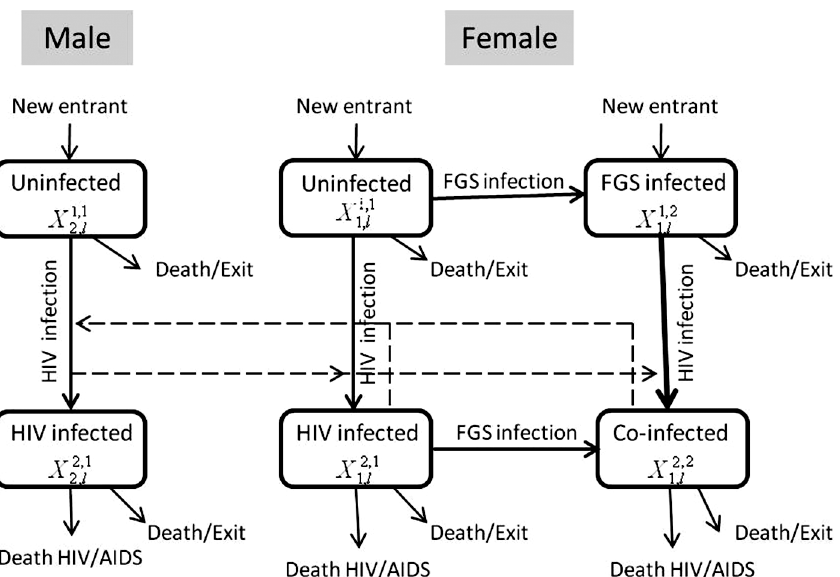
Figure 1. Outline of FGS-HIV transmission model. The flow between epidemiological classes for the transmission dynamics of FGS and HIV. Individuals enter the system at age 15, and exit at age 50. X 1,1 and FGS, infected with FGS, infected with HIV, and infected with both HIV and FGS. X 1,1 and infected with HIV.